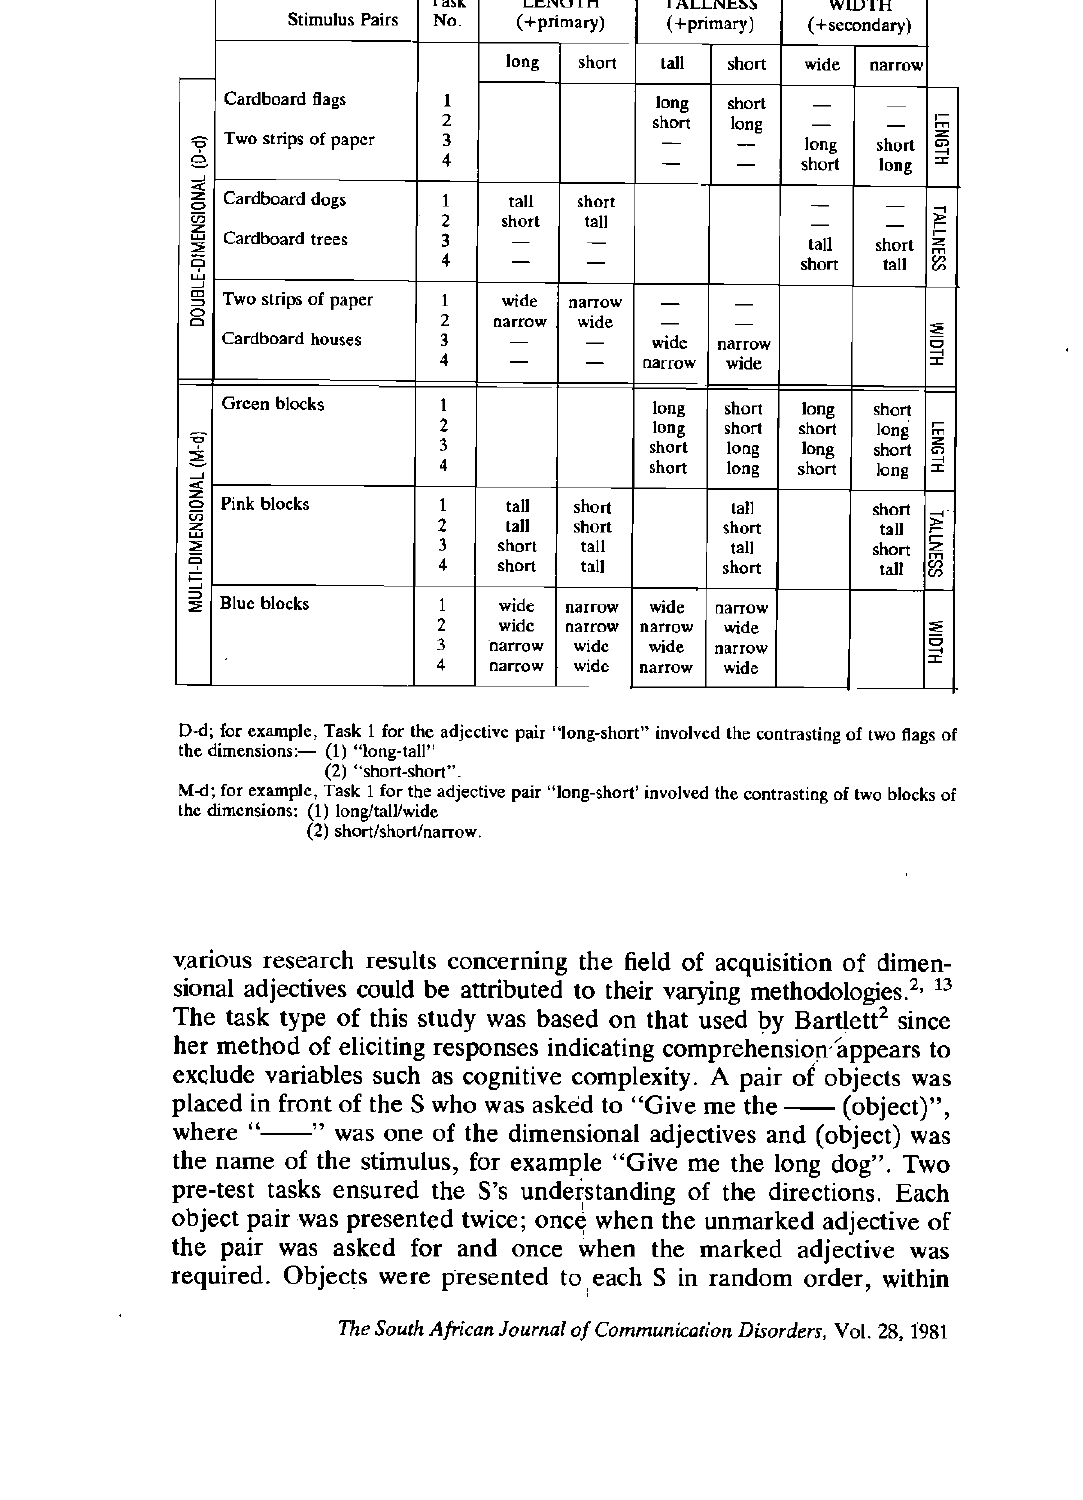
Task LENGTH No. (+primary) long short tall short wide narrow 1 2 3 4